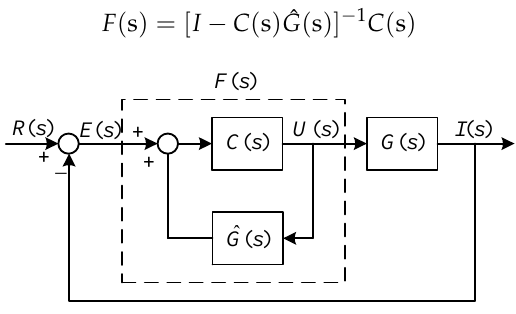
Figure 4. Schematic diagram of IMC.